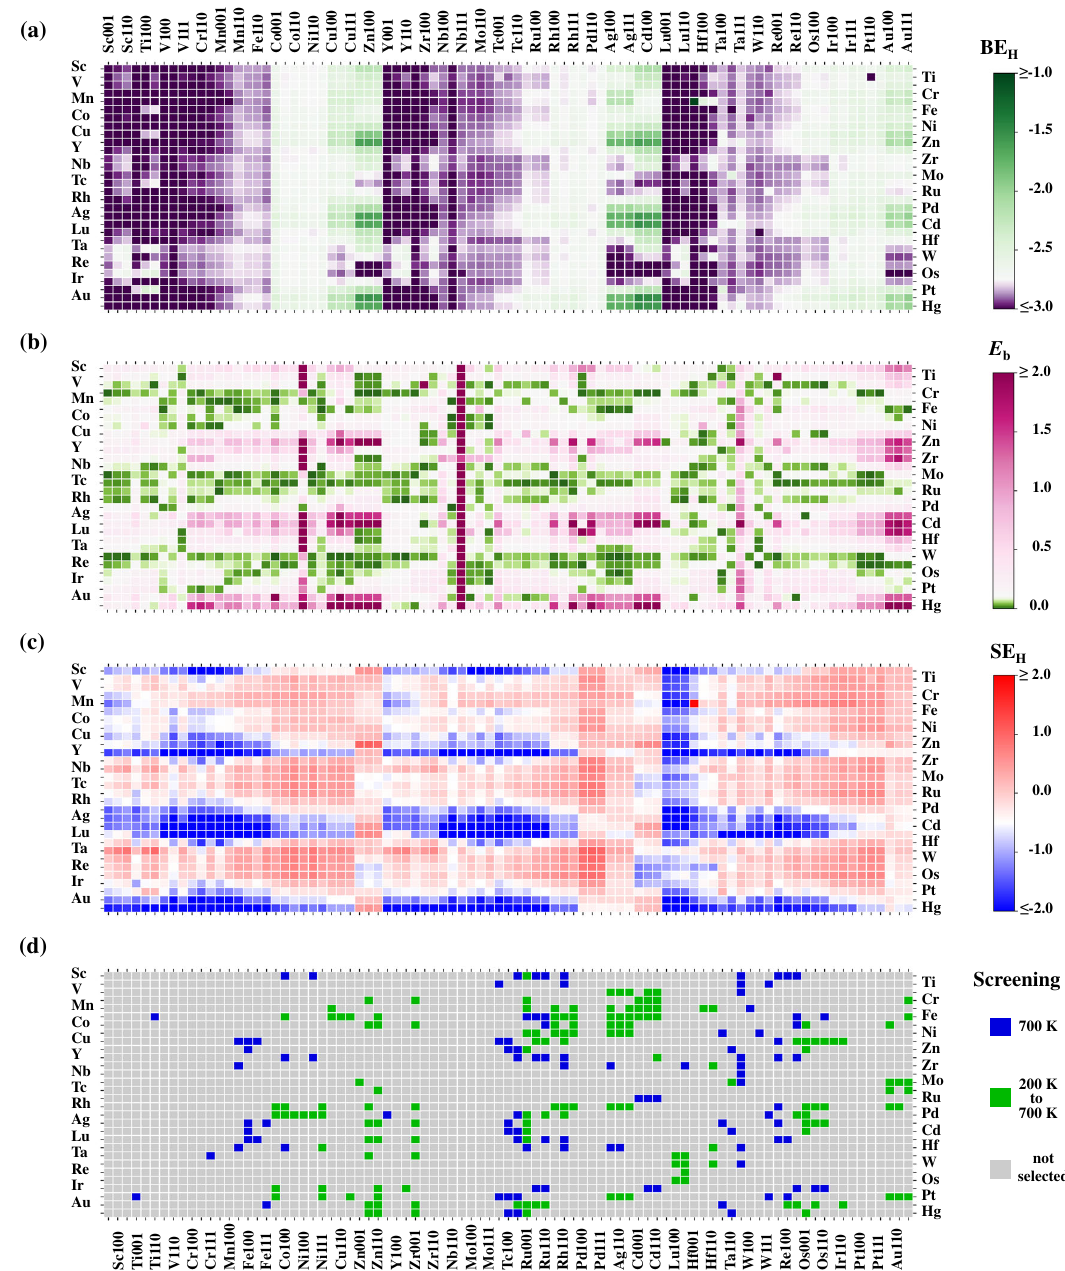
Fig. 3 Results of high-throughput screening of SAACs with SISSO. Results for a BE H , b E b , and c SE H are shown. The promising candidates at different temperatures T are highlighted in d . Vertical axis displays the guest atom type, and the horizontal axis displays the host metal surfaces with different surface